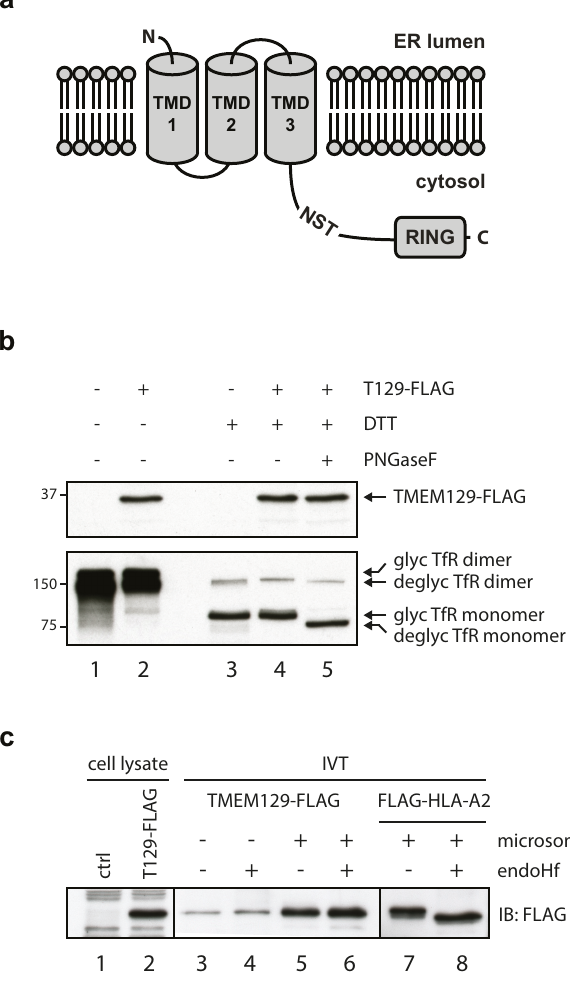
Figure 1. Transmembrane protein 129 (TMEM129) does not contain disulphide bonds, N -linked glycans, nor a cleavable signal sequence. ( a ) Predicted TMEM129 topology according to the TOPCONS membrane protein topology prediction program. Indicated are the predicted transmembrane domains (TMD) 1–3 and a putative endogenous glycosylation site (NST). ER, endoplasmic reticulum; ( b ) TMEM129 does not contain intermolecular disulphide bonds and is not